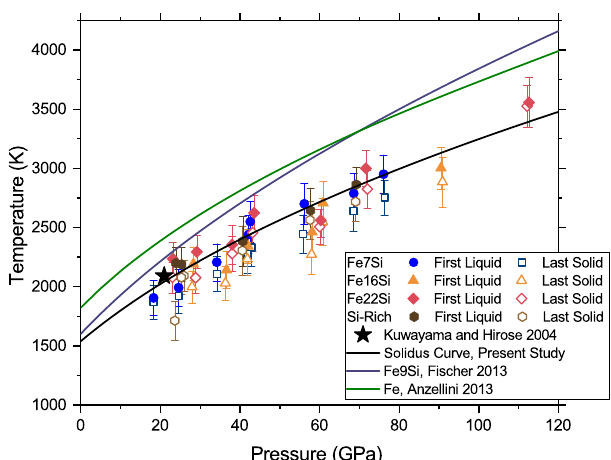
Fig. 2 Melting temperatures in the Fe – FeSi system at high pressures. Pressure-temperature points at which liquid diffuse scattering is fi rst detected (solid symbols) and the last diffraction pattern prior (open symbols). Solid lines indicate estimated solidus temperatures of the Fe – Si system from the present study and available literature. Error bars in temperature represent one standard deviation. Solid black line shows a Simon – Glatzel fi t to the present dataset with parameters T 0 = 1538 K, a = 24.66, c = 2.17 84